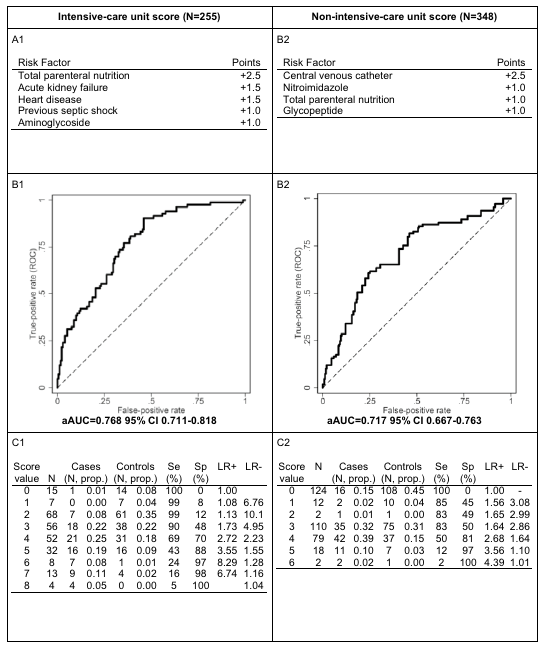
Fig. 1 Risk scores for candidemia CO‑02 A stronger signal of